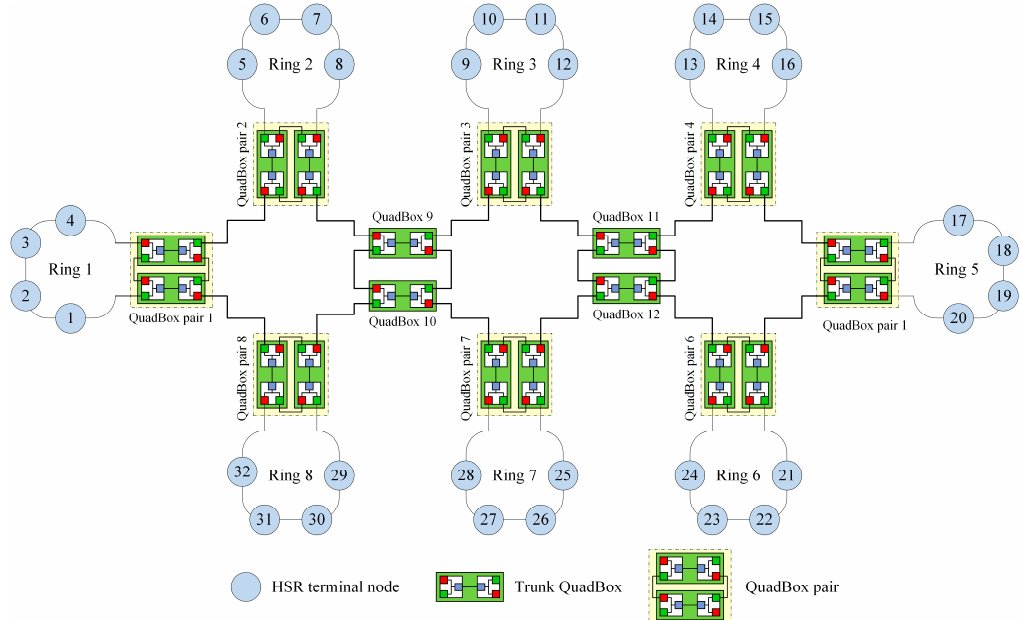
Figure 5. A sample high-availability seamless redundancy (HSR) connected-ring network.